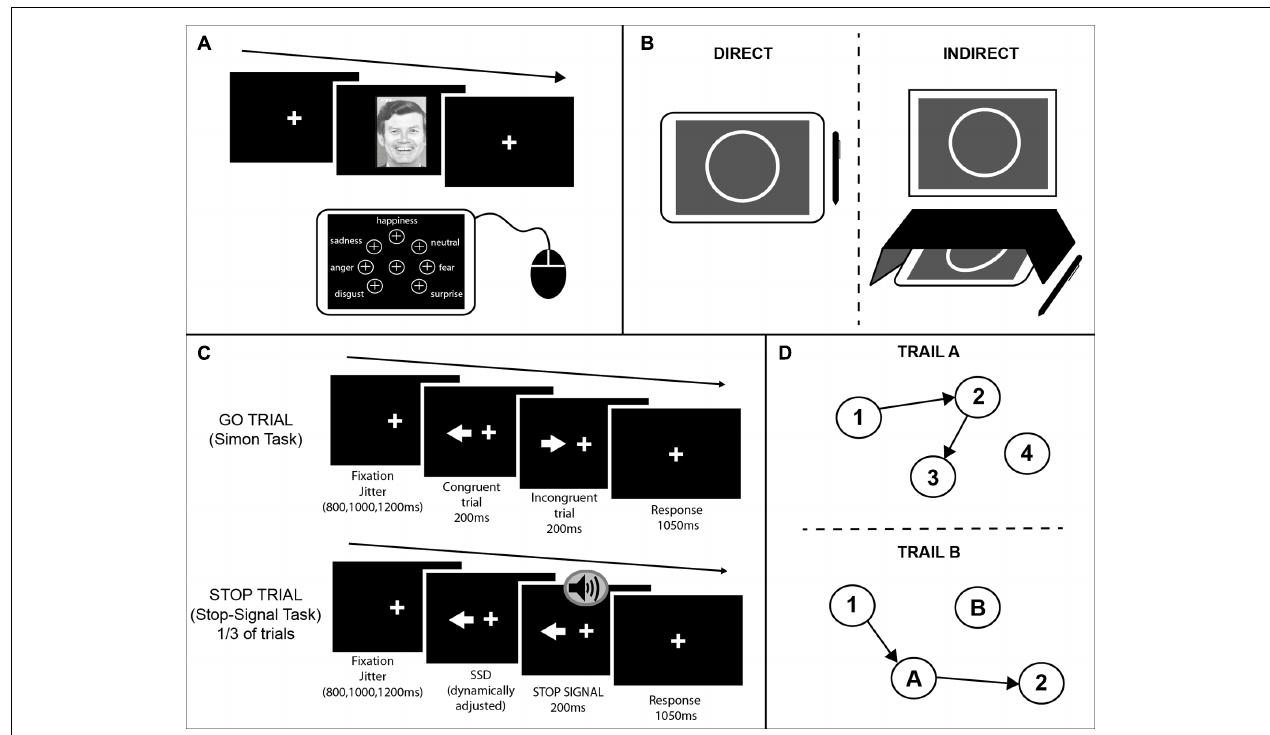
FIGURE 1 | Schematics of the cognitive tasks used. (A) Emotion recognition task. A face was presented on an external monitor positioned in front of the participants. On each trial subjects were instructed to identify the emotion of the face presented on the screen and select one of seven options that appeared on the tablet screen using a mouse. The buttons for each of the seven emotions were arranged in equal distance away from the center button. (B) Circle tracing task. Participants were instructed to use a stylus to trace a white circle on a gray background. For the direct condition (Left) participants were instructed to trace the circle on the tablet screen. For the indirect condition (Right) a box was placed over the tablet so the participants could not see their hand; the circle was projected onto an upright monitor in front of the participant. (C) Combined Simon-Stop-Signal Task. A white arrow was presented on an upright monitor either side of the fixation cross pointing in the left or right direction. Participants were instructed to respond with their left or right index finger to the direction in which the arrow was pointing and ignore the location of the arrow (Simon task). On congruent (C) trials the arrow pointed in the same direction as the location in which it appeared on the screen. On incongruent (IC) trials the arrow pointed in the opposite direction to the side of the screen it appeared. On 30% of trials, an auditory stop-signal was given and subjects were instructed to inhibit their response [stop trials; Stop-Signal Task (SST)]. (D) Trail Making Test. A modified computerized version of the PEBL was administered using a touchscreen and stylus. The test included two parts both of which consisted of 25 circles randomly scattered over the touchscreen surface. In part A (Upper) these circles were numbered 1–25 and participants were instructed to tap inside the circles in ascending order using the stylus. In part B (Lower) the circles included numbers (1–13) and letters (A–L). Participants were instructed to tap inside the circles in ascending order alternating between numbers and letters (1–A–2–B, etc.). Three different versions of each part were used and counterbalanced across participants and sessions.